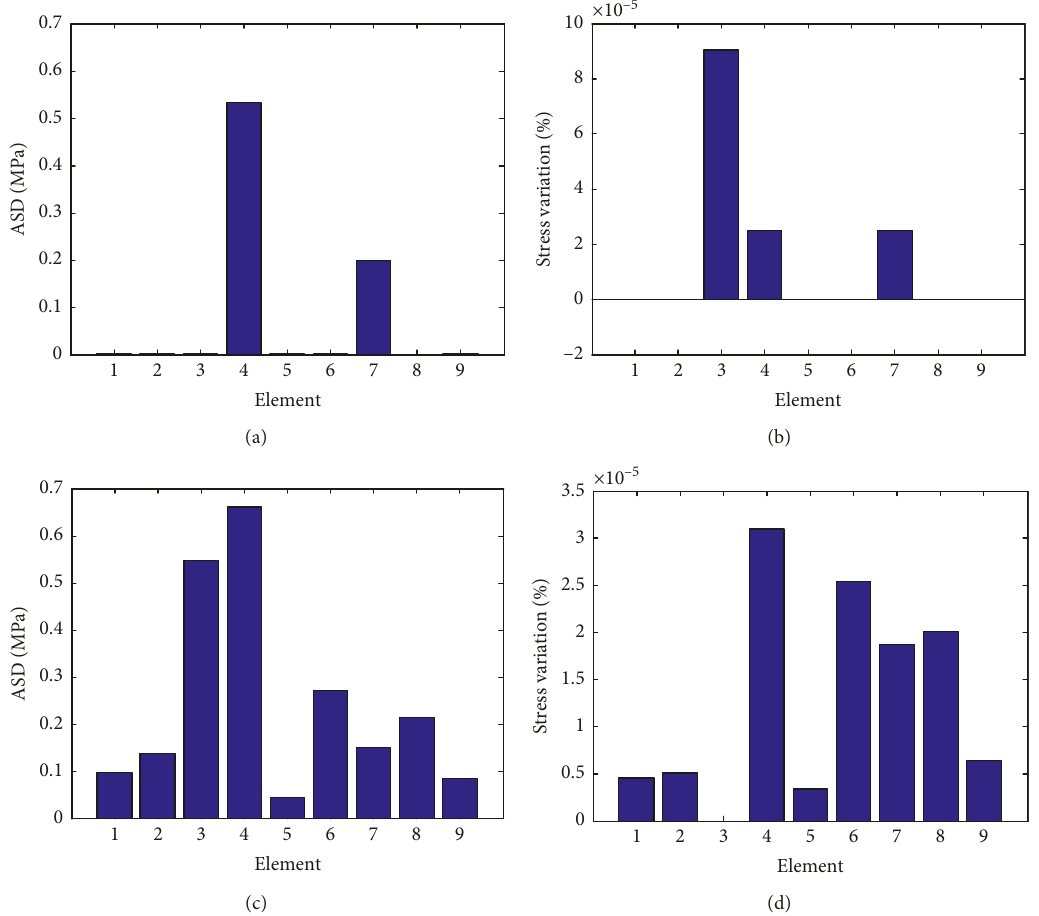
Figure 5: Multiple damages at elements ④ and ⑦ using the global-based approach of (a) ASD of noise-free, (b) stress change rate of noise- free, (c) ASD of 5% noise, and (d) stress change rate of 5%